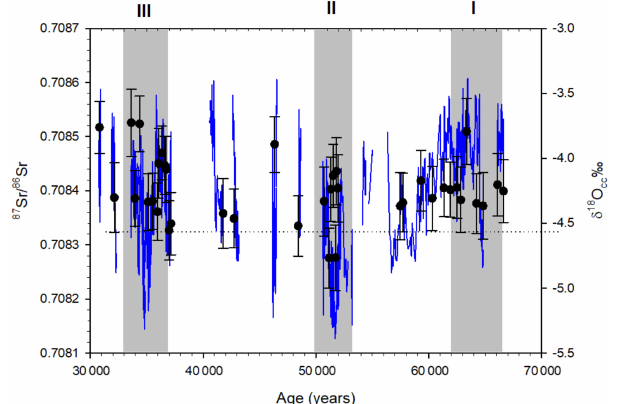
Figure 7. 87 Sr / 86 Sr record for SC-06-01, compared to calcite δ 18 O cc record (light grey line). Error bars are 2 σ . Growth Phases I, II and III are shown as grey areas.